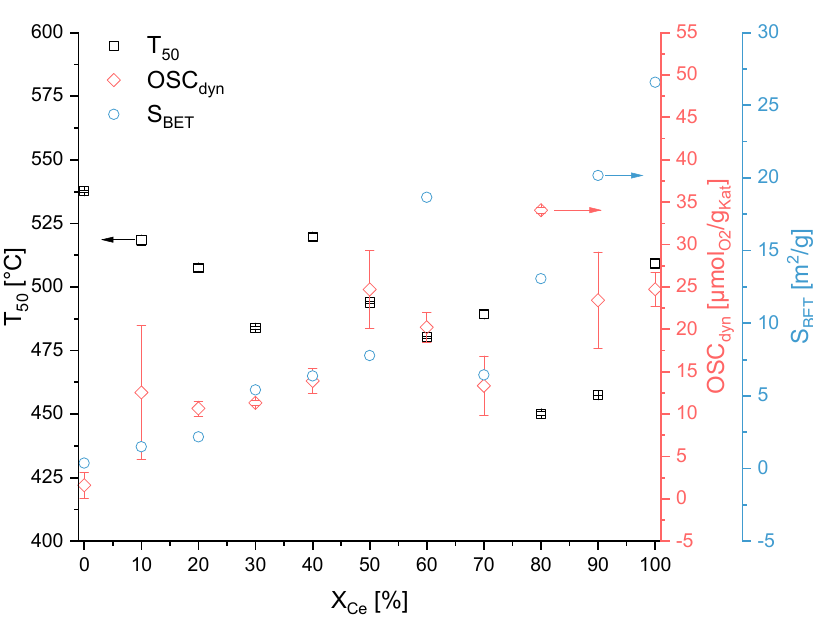
Figure 4. T 50 (tight contact), S BET and OSC dyn values in dependence of the nominal molar Ce content for samples prepared by normal precipitation. Shown are duplicate measurements together with their standard deviation.